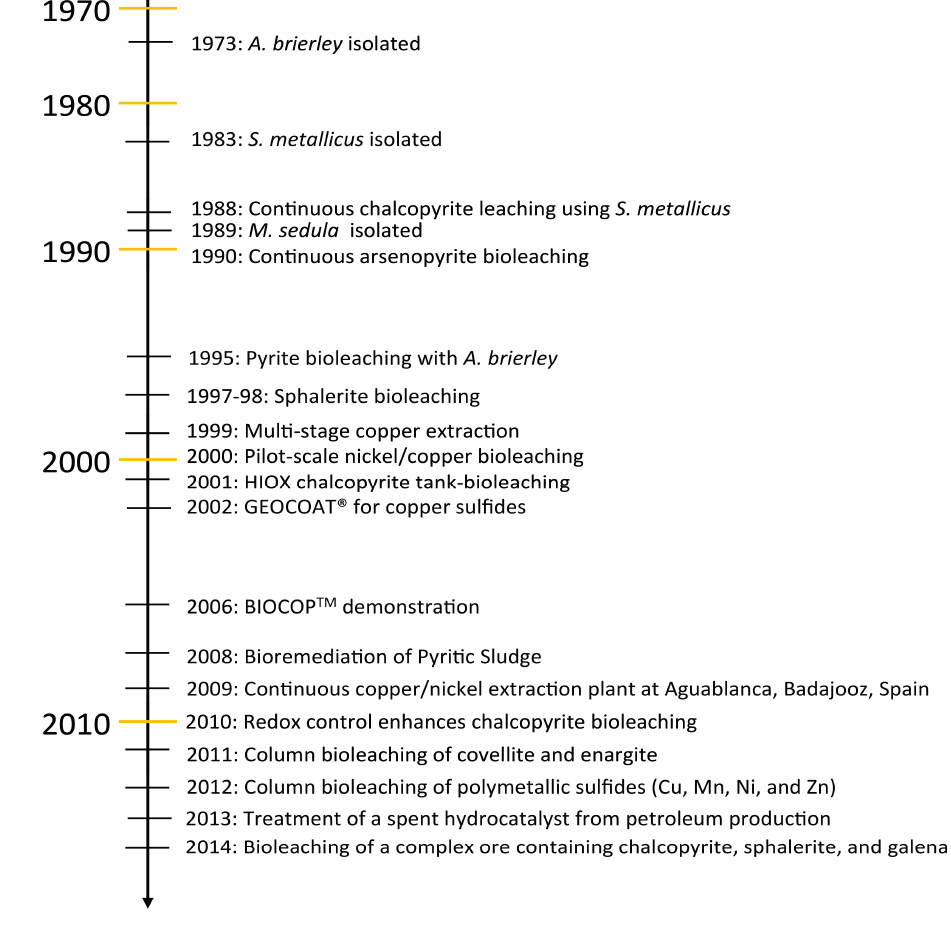
Figure 4. Chronology of selected developments in extreme thermoacidophilic biotechnology